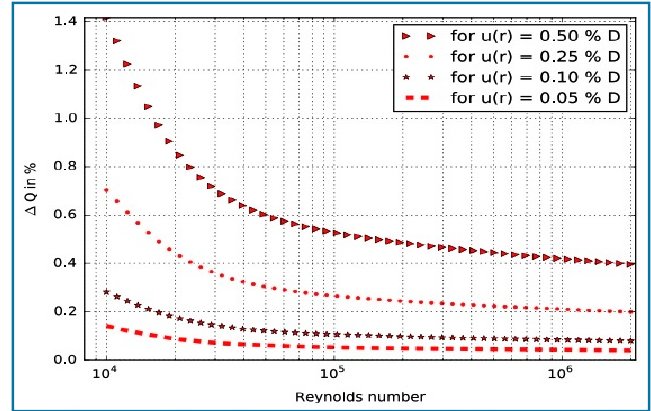
Figure 26. Influence of positional accuracy on the flow-rate velocity according to the Chebyshev method at (k = 1).